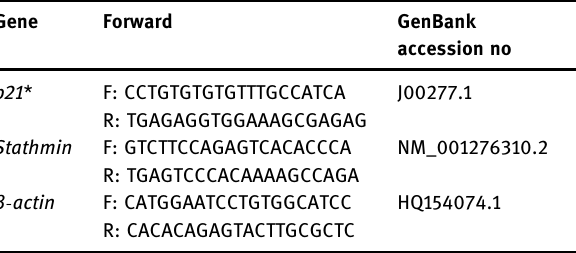
Table 1: Primers sequence used for RT - qPCR of lung and breast cancer cell